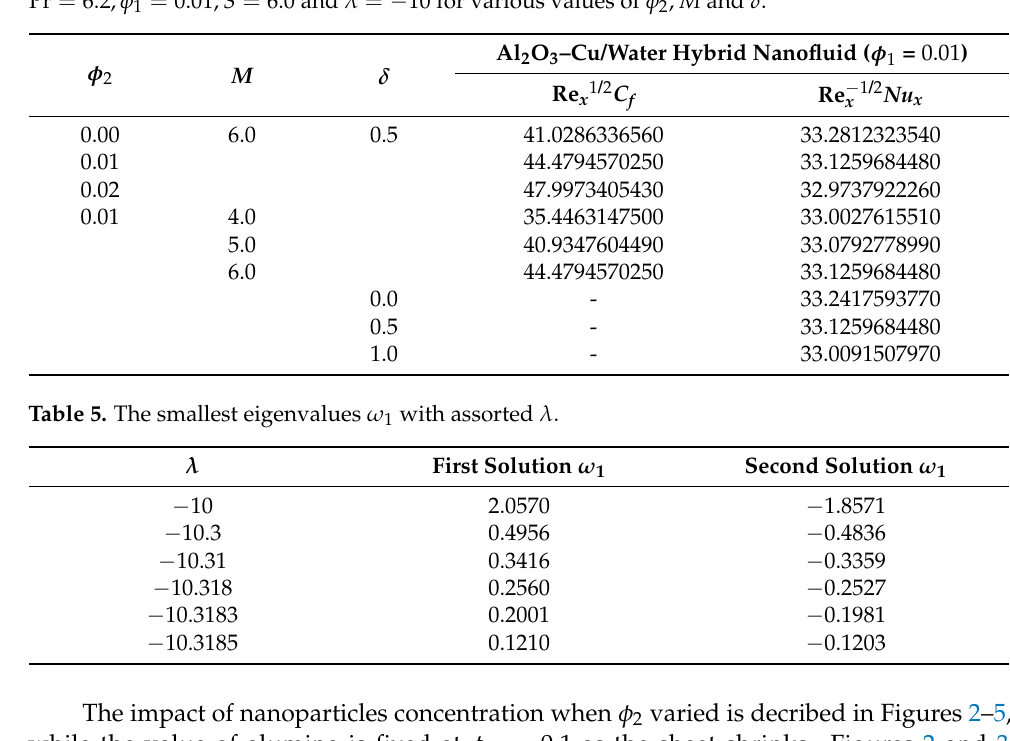
φ . Figure 2. f (cid:48)(cid:48) ( 0 ) against λ by various φ 2 2